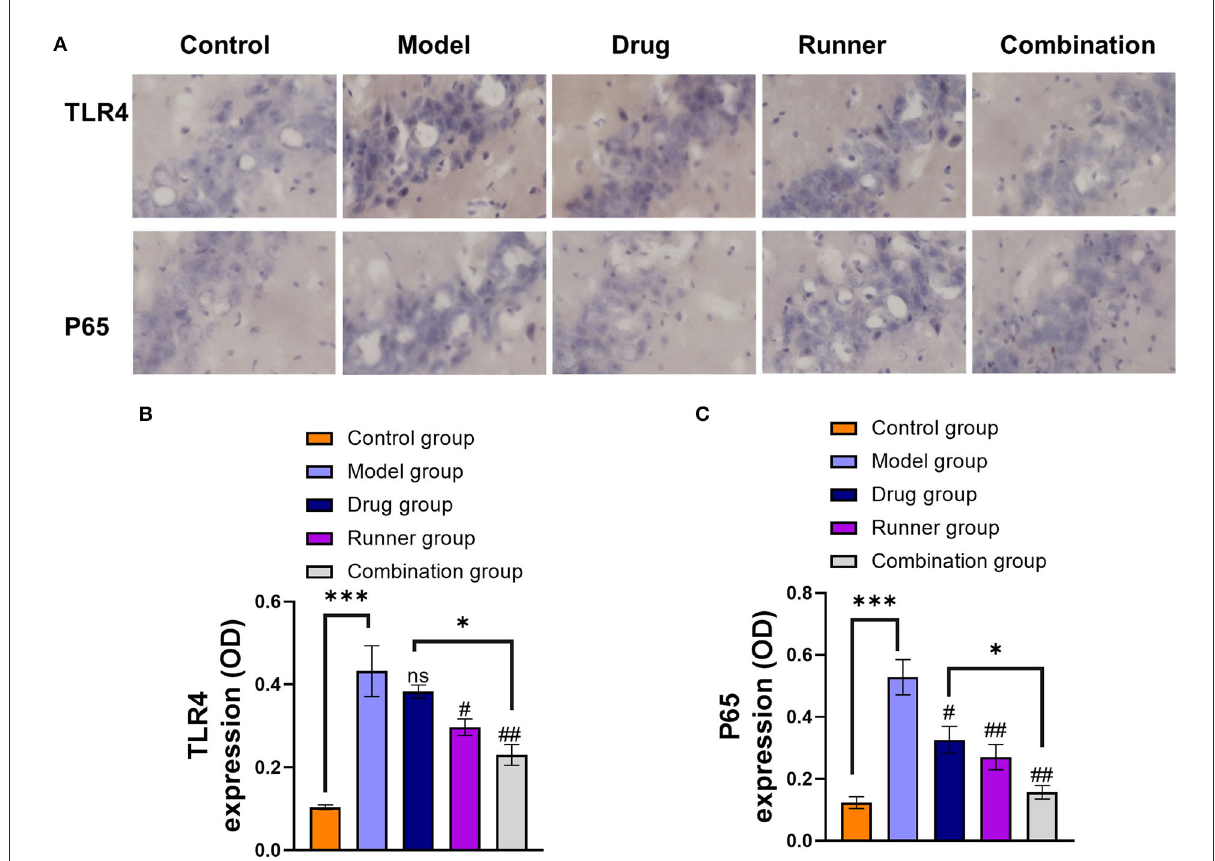
FIGURE7 Effect of LE-VPA on TLR4/ NF-kB activation in the hippocampus. (A) Five brain slices were processed for TLR4 and NF- κ B p65 immunohistochemical staining. Experiments were performed three times, and the staining of the cells under a 20x microscope was shown. (B,C) Comparison of the IODs of TLR4 and p65 using immunohistochemical staining in the hippocampus from each group. The data were expressed as the mean ± SEM. ns > 0.05, * P < 0.05, *** P < 0.001; # P < 0.05, ## P < 0.01, compared with model group (two-way